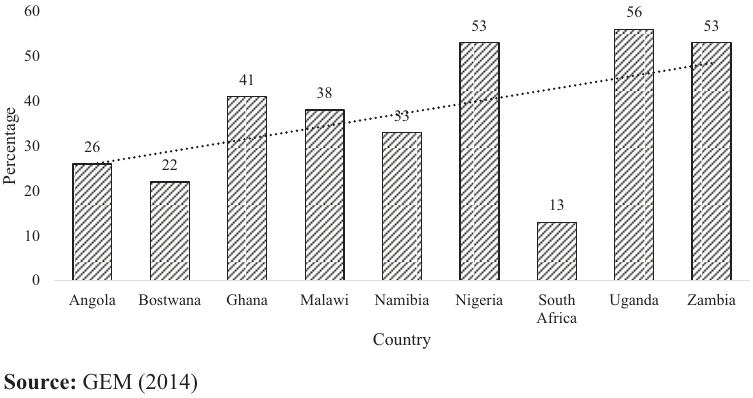
Figure 3. Percentage of